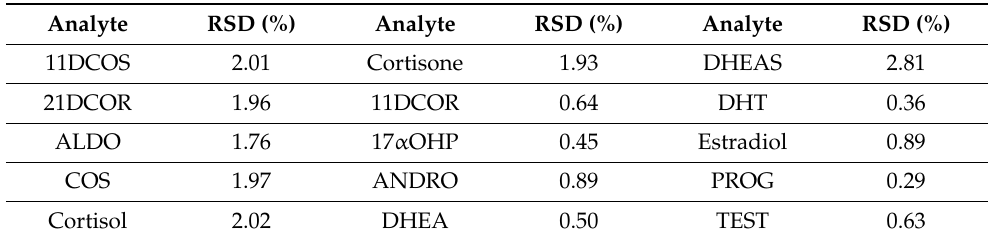
Table 1. The reproducibility of retention time during between-run measurements for all QC concen- trations (3 moths) is given in relative standard deviation %